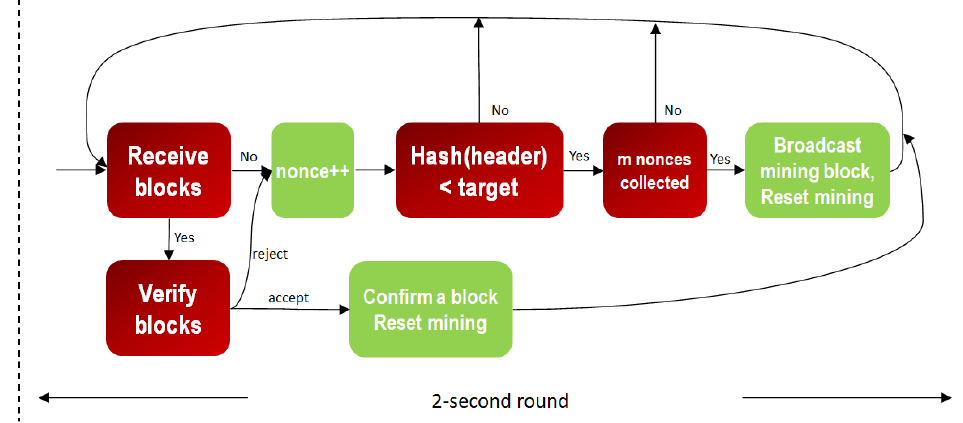
Figure 3. Mining flow of conservative GPoW model.